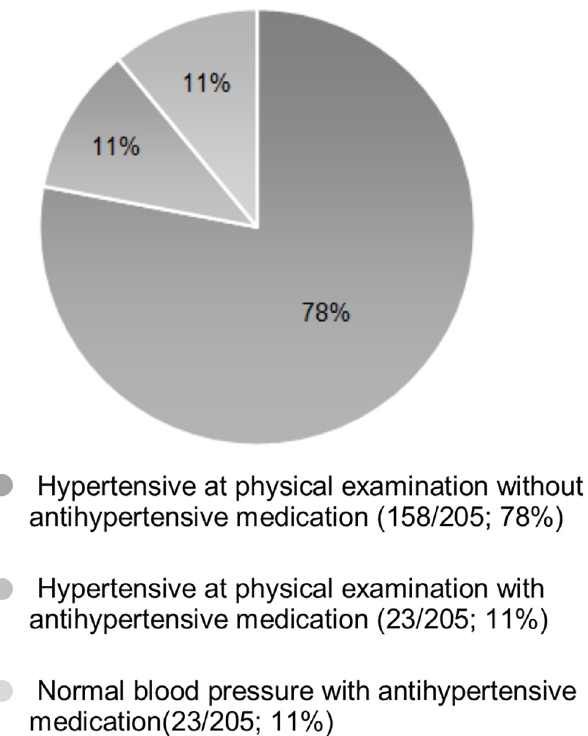
Fig 1. Hypertensive Control in HIV-positive patients (N = 205). Included subjects from the cohort of 903 HIV-positive patients: 205 patients, previously diagnosed with hypertension or in whom hypertension was newly diagnosed. Hypertensive = systolic blood pressure (cid:1) 140 mmHg and/or diastolic blood pressure (cid:1) 90 mmHg.